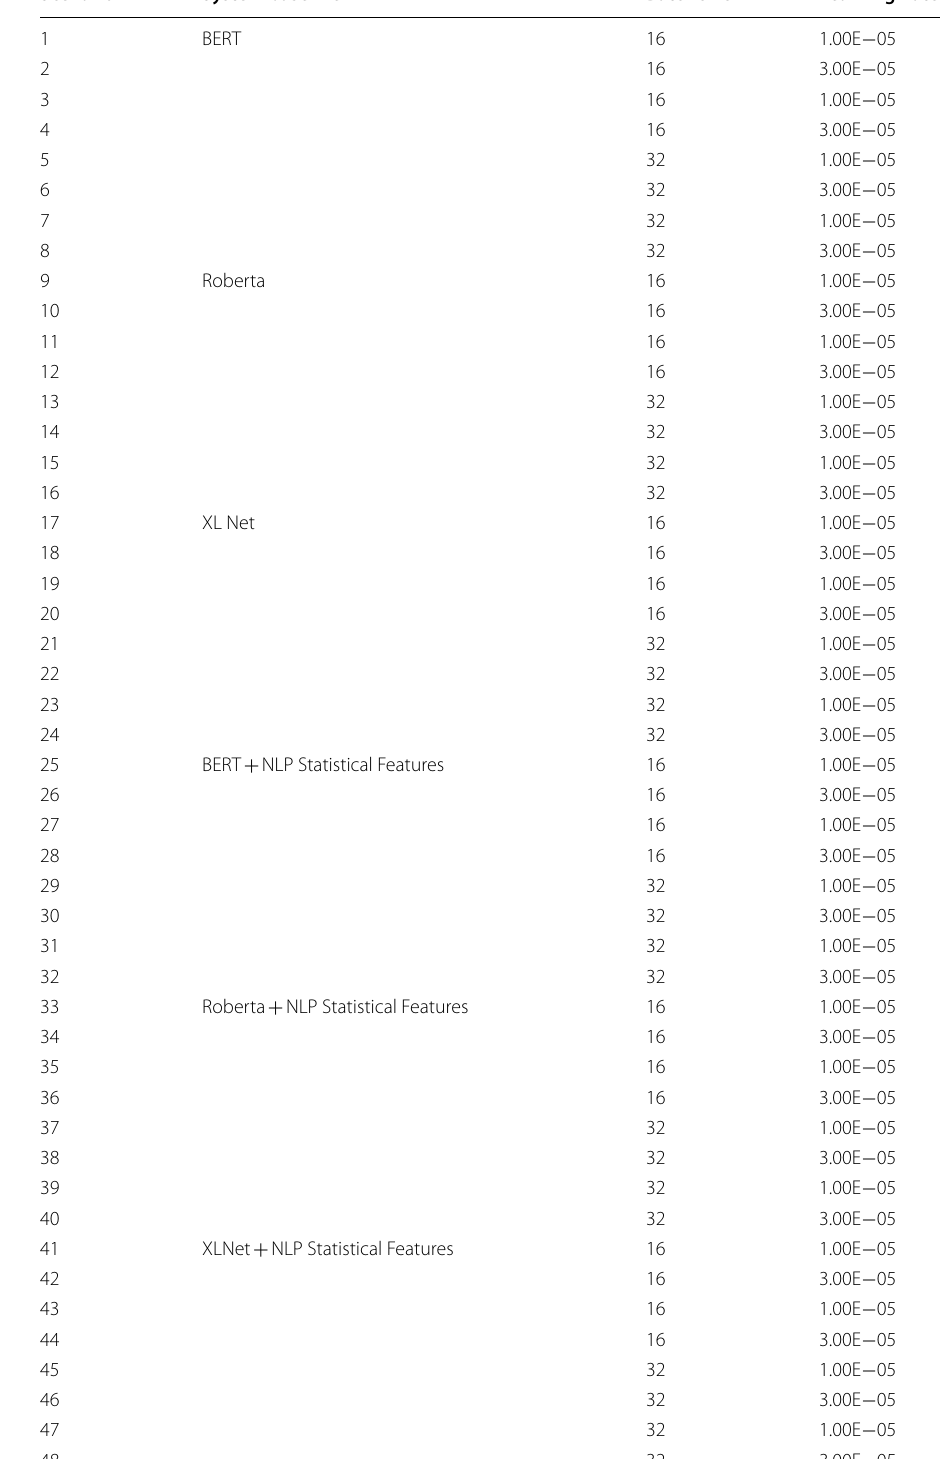
Table 6 Experimental design